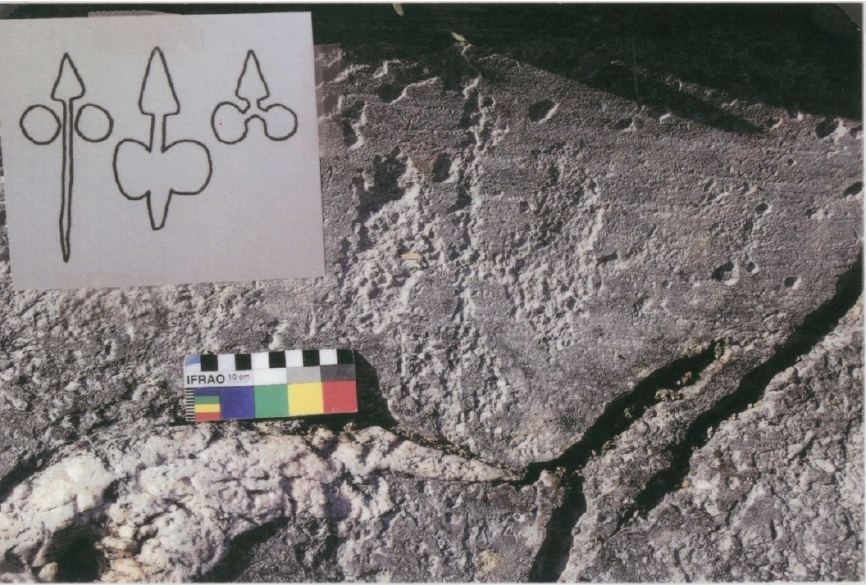
Figure 15. A “bilobate spear” of Mississippian culture, ca. A.D. 1100–1250. This shows clear southern influences. Photo by